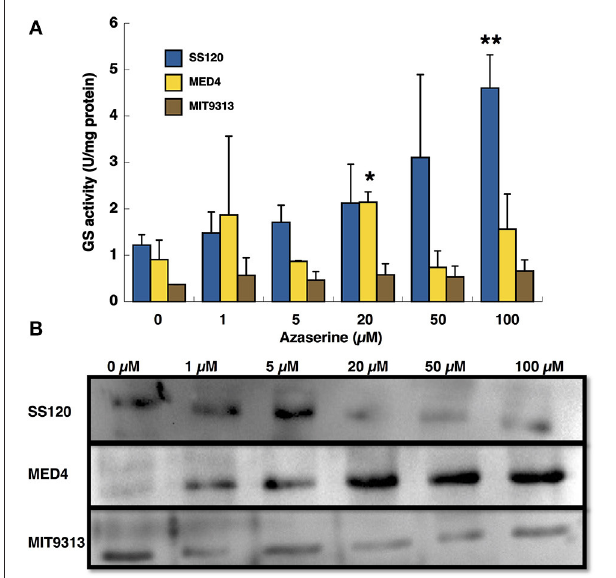
FIGURE 1 | Effect of different concentration of azaserine on GS activity (A) and GS protein concentration (B) in different strains from Prochlorococcus. The different concentrations of azaserine were added to the cultures and cells were collected after 24h of treatment. (A) is a representation of three independent biological replicates of each strain. Error bars correspond to standard deviation. (B) corresponds to a Western blotting using anti-GS antibodies.